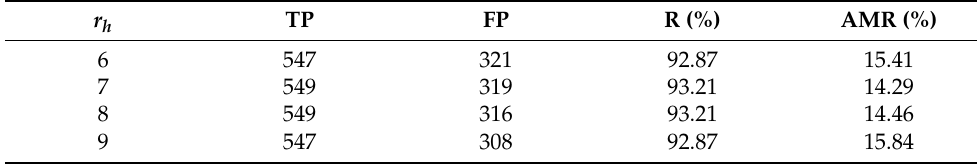
Table 3. Comparison of different r h values in the integrated